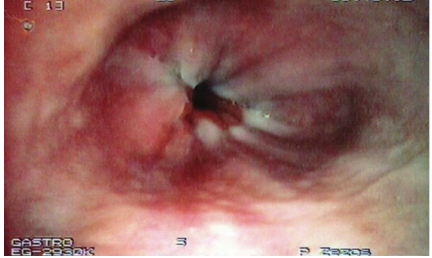
Figure 3: Follow-up with upper gastrointestinal endoscopy show- ing complete healing of the esophageal erosions after 3 months of topical treatment with swallowed